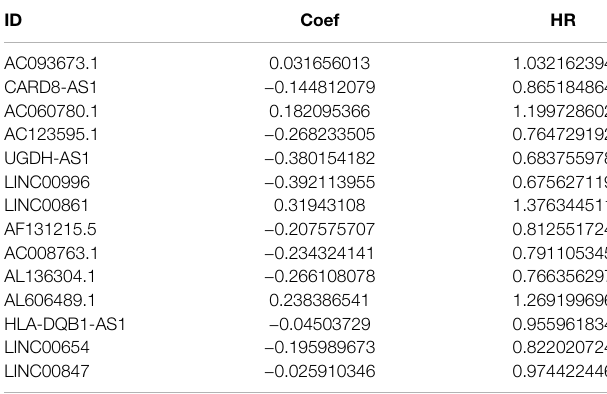
TABLE 1 | The regression coef fi cient of each ARlncRNA included by the multivariate Cox analysis. ID